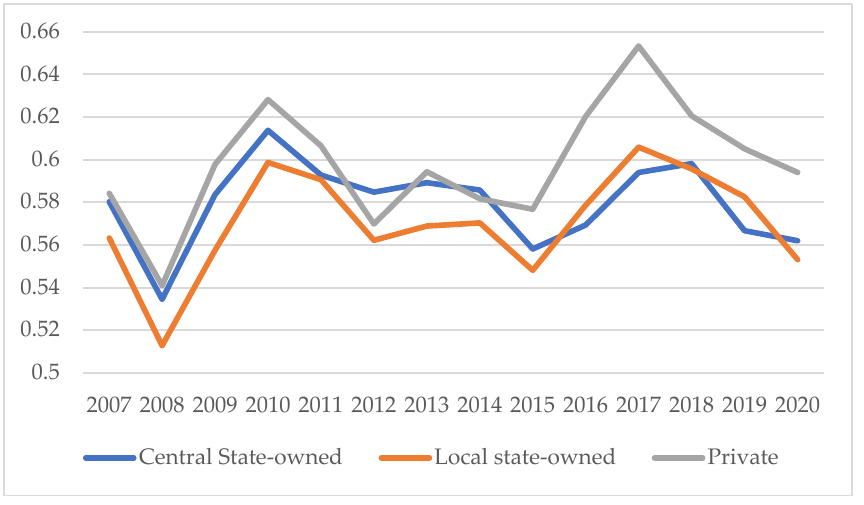
Figure 1. Trends of technical efficiency change of enterprises under all kinds of ownership in 2007–2020.